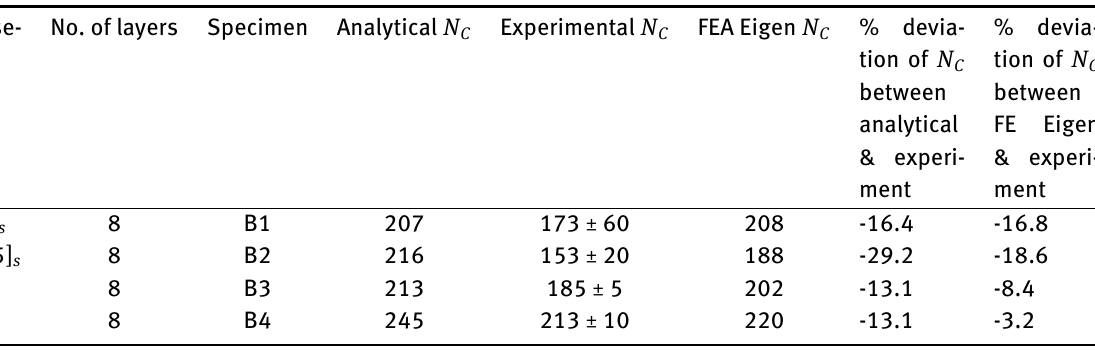
Table 5: Comparison of critical buckling load from experiment, analytical (CLPT), and finite element eigen solution when the set target buck- ling load is